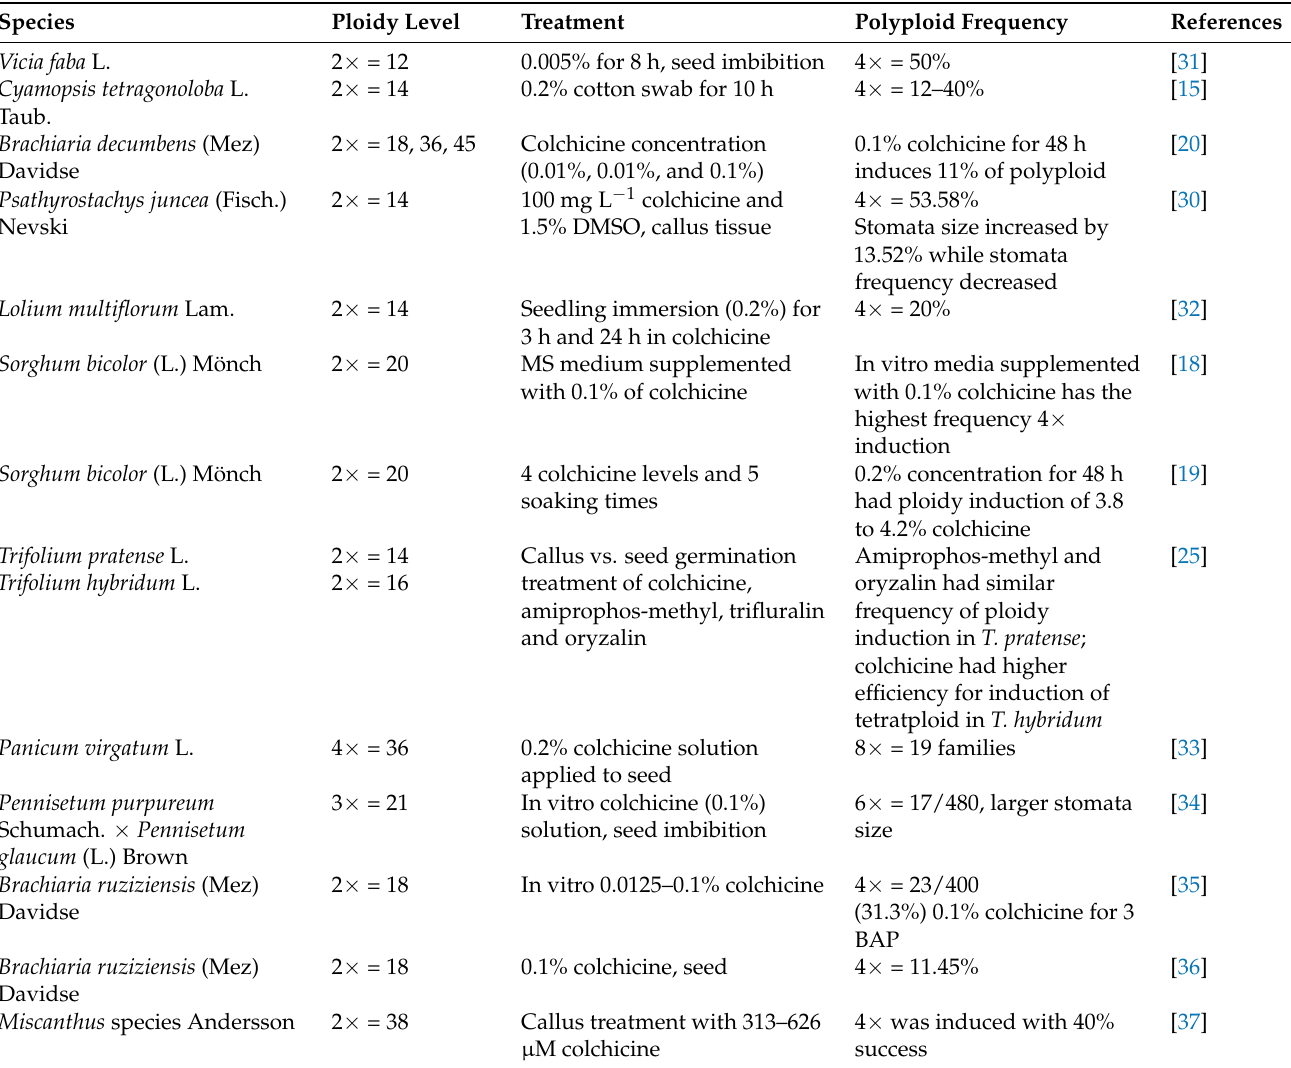
Table 1. Recovery of induced tetraploids using various concentrations of anti-mitotic